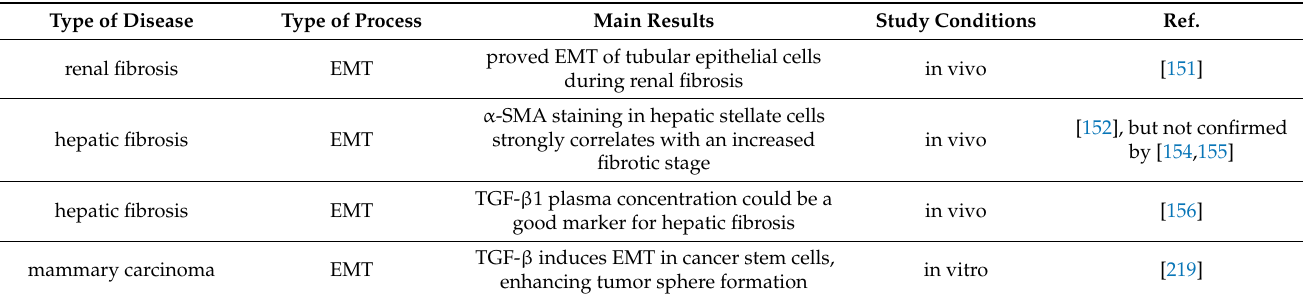
Table 1. Main results of epithelial-to-mesenchymal transition (EMT) and mesenchymal-to-epithelial transition (MET) reported in the canine